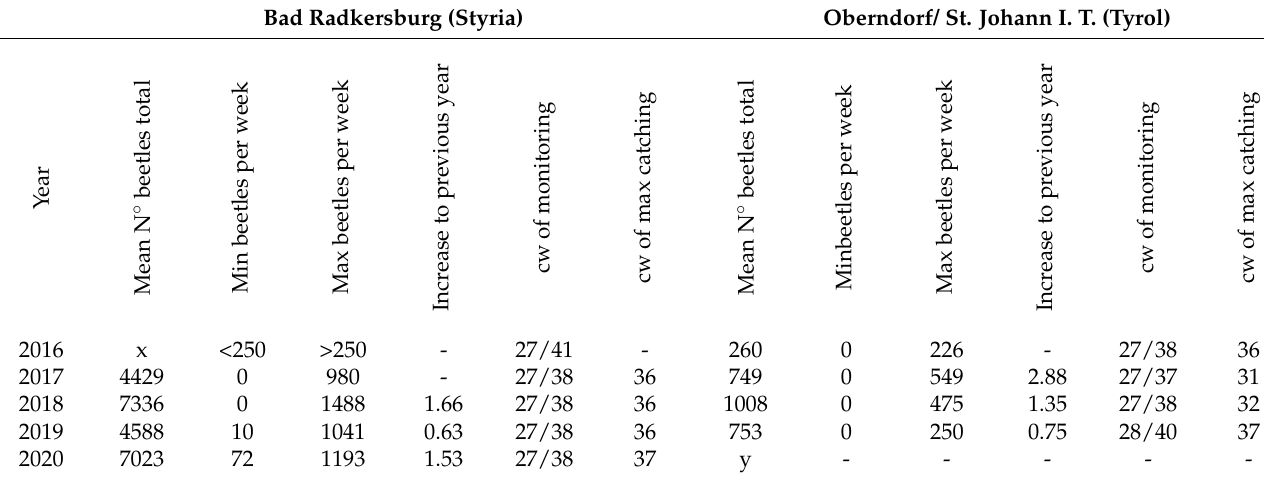
Table 1. Number of beetles in the trial region evaluated with PAL sticky traps (CSALOMON TM , Hungary) in the regions Bad Radkersburg and Oberndorf/St. Johann in Tyrol from 2016 to 2020. Shown is the mean number of beetles over the season per trap with minimum (min) and maximum (max) number of beetles per week.